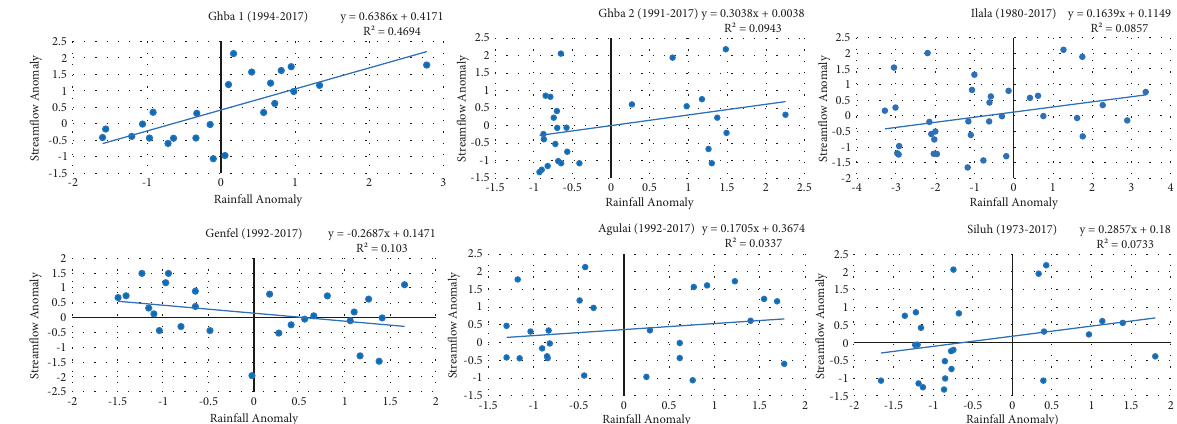
Figure 12: Relationship between rainfall and streamflow trend in the Ghba